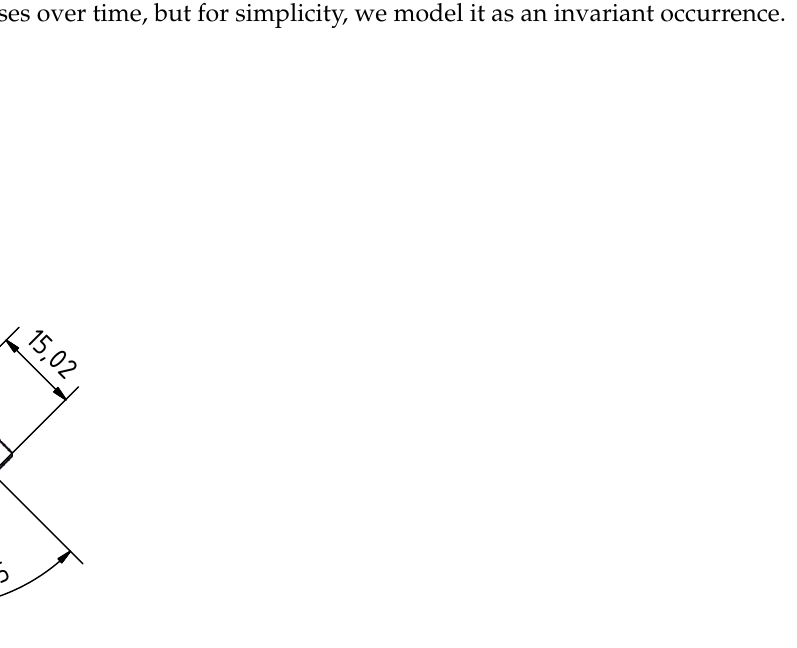
Figure 4. Setup of the clogging model showing the obstacle position with respect to the SEN. The obstacle is positioned to cover half of the SEN outlet and has an additional 15 mm long extension directed downward at an angle of 45°. Outlets of the SEN are directed downward at an angle of